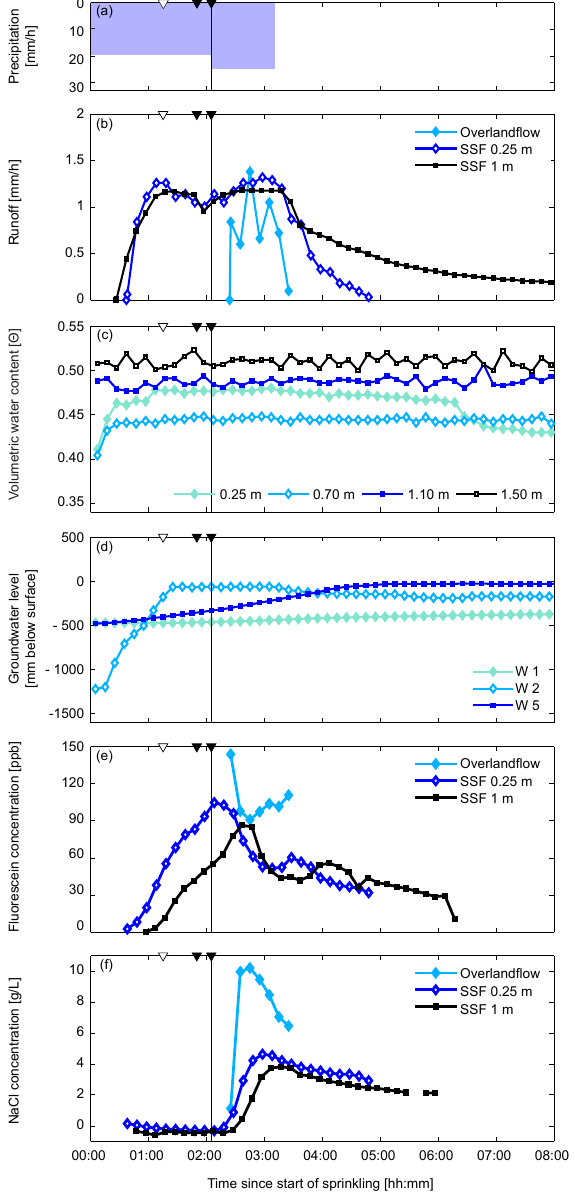
Fig. 4. First sprinkling experiment on 3 August 2011 at the Ru- Fig. 4 1 st sprinkling experiment on 03.08.2011 at the Rufiberg’s 10 m x 10 m plot (Fig. 1). 2 fiberg’s 10m × 10m plot (Fig. 1). (a) Precipitation (total artifi- (a) Precipitation (total artificial rainfall 65 mm + 2.2 mm s natural rainfall; 7 mm natural rainfall 3 cial rainfall 65mm + 2.2mm natural rainfall; 7mm natural rain- occurred in the hours before the sprinkling). (b) Runoff in surface flow collector and subsurface 4 fall occurred in the hours before the sprinkling). (b) Runoff in drainage at 0.05, 0.25 and 1.0 m depth (Fig. 1). (c) Volumetric water content measured at TDR nest 5 surface flow collector and subsurface drainage at 0.05, 0.25 and T1. (d) Groundwater dynamics in monitoring wells W1, W2, and W5 (no data for W6 due to 6 1.0m depth (Fig. 1). (c) Volumetric water content measured at TDR malfunctioning of sensor-logger unit). (e) Fluorescein tracer breakthrough curve and (f) NaCl tracer 7 nest T1. (d) Groundwater dynamics in monitoring wells W1, W2, breakthrough curve in surface flow at 0.05 m depth, shallow subsurface flow at 0.25 m depth, and 8 and W5 (no data for W6 due to malfunctioning of sensor-logger deep subsurface flow at 1.0 m depth. The white triangle ( s ) represents the onset of 2.2 mm natural 9 unit). (e) Fluorescein tracer breakthrough curve and (f) NaCl tracer precipitation, the black triangles ( q ) indicate two 5 min irrigation stops for sprinkler cleaning. The 10 breakthrough curve in surface flow at 0.05m depth, shallow subsur- black line (|) indicates a change in irrigation intensity from 20 to 25 mm h -1 and the NaCl tracer 11 face flow at 0.25m depth, and deep subsurface flow at 1.0m depth. application. 12 The white triangle represents the onset of 2.2mm natural precip- itation, the black triangles indicate two 5min irrigation stops for sprinkler cleaning. The black line indicates a change in irrigation intensity from 20 to 25mmh − 1 and the NaCl tracer application.